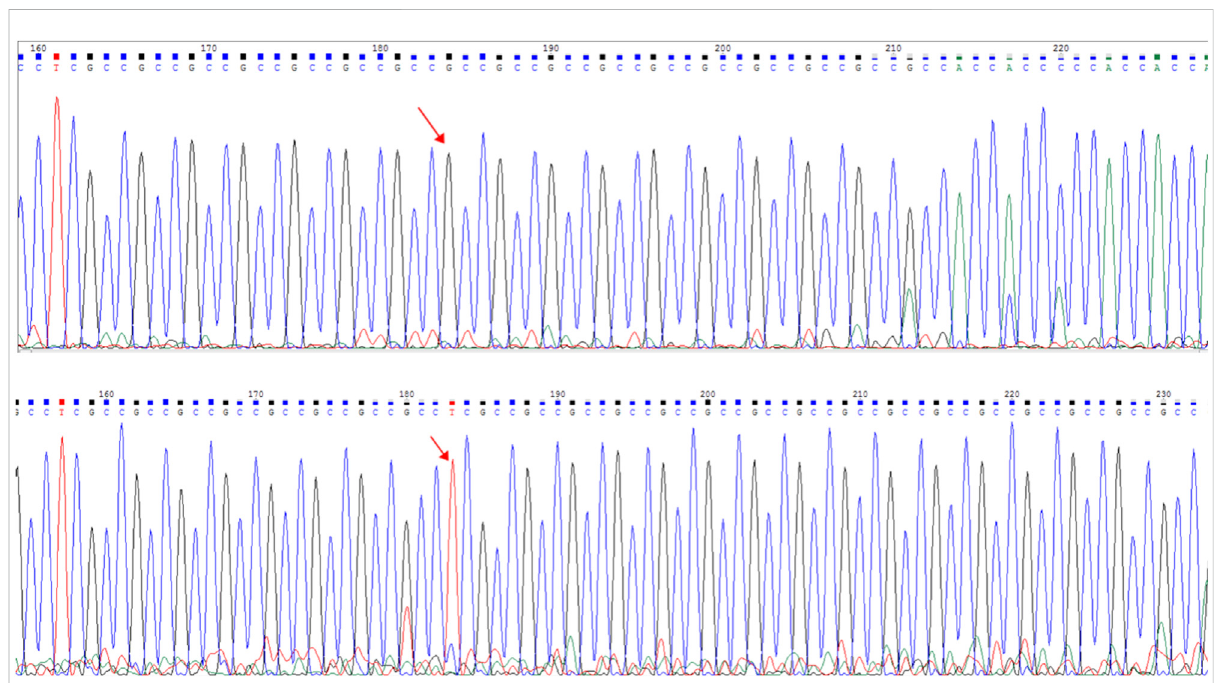
FIGURE 7 Capillary electrophoresis electropherogram of the AR gene revealed the existence of different mutations (red arrow): C.1395_1396insGA: p.G465fs. Sanger sequencing peak map. The electropherogram at the top corresponds to the mother (I-2), while the bottom electropherogram corresponds to the proband